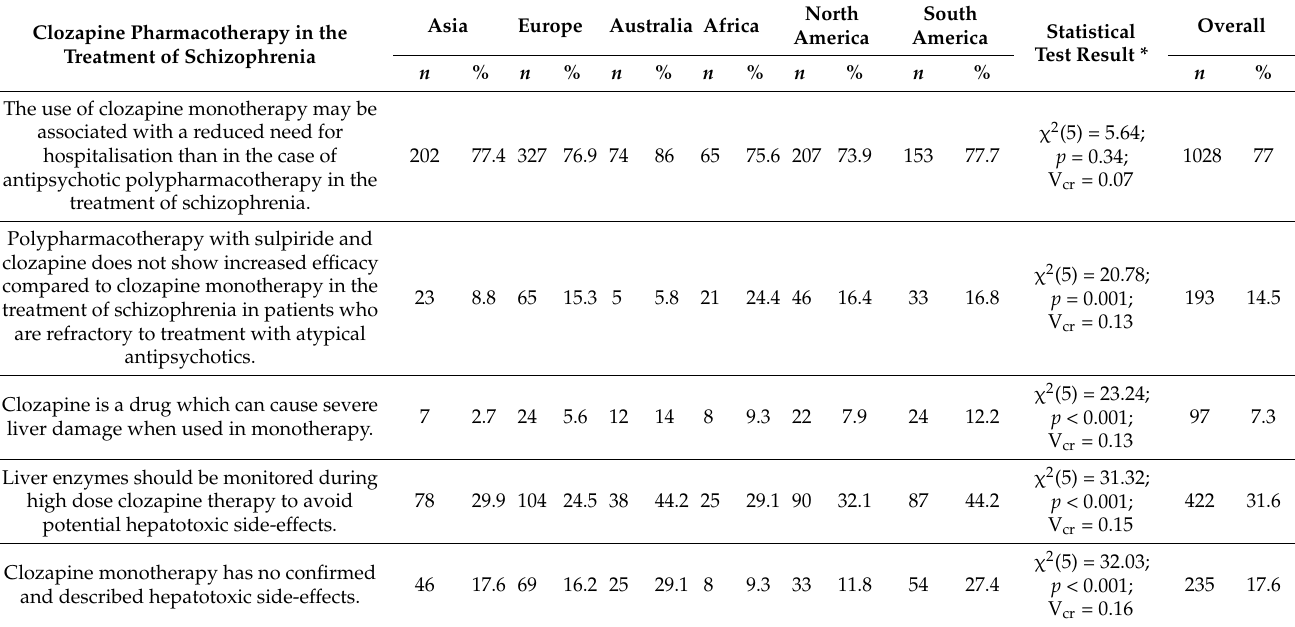
Table 5. Psychiatrists’ answers on the clozapine pharmacotherapy in the treatment of schizophrenia.